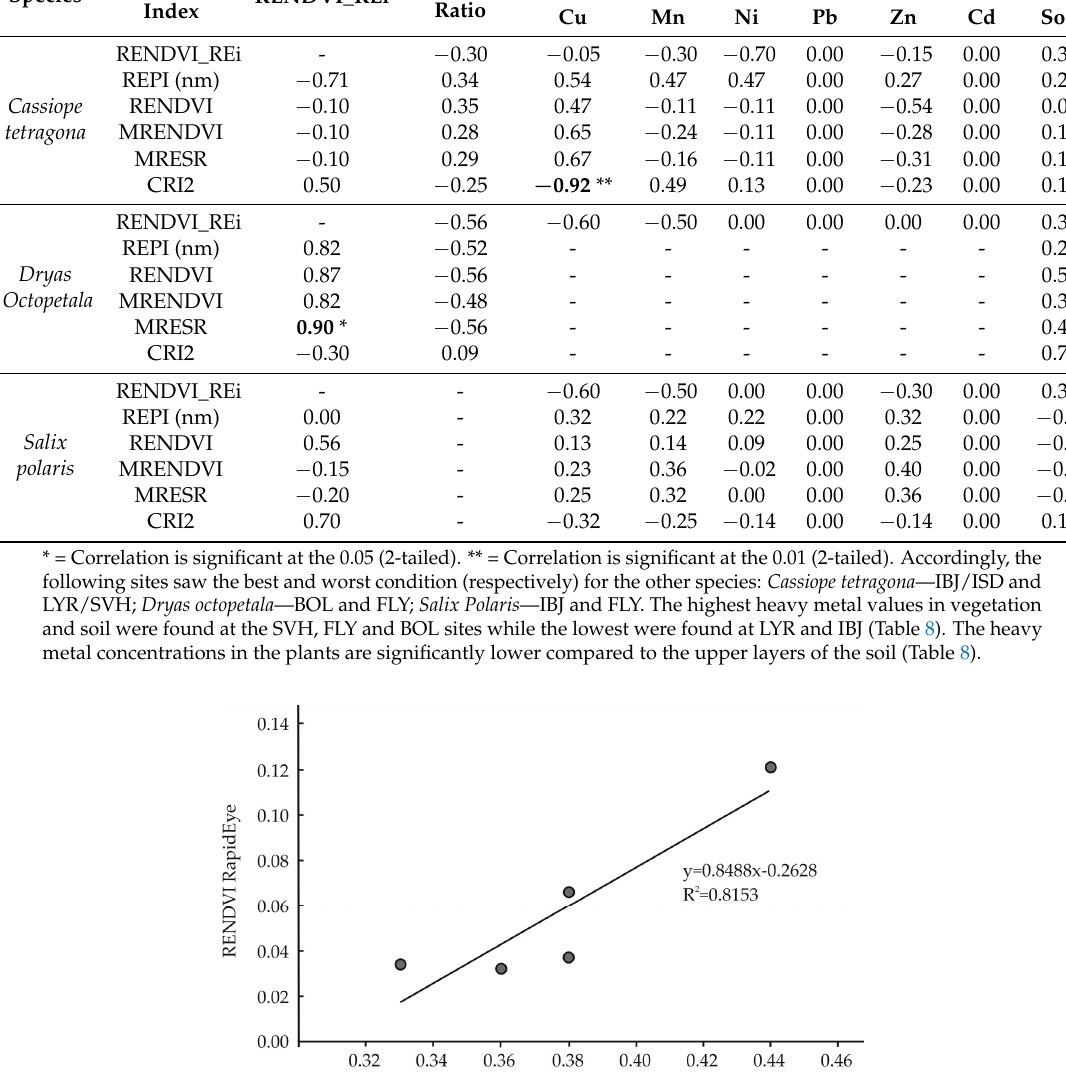
Table 9. Calculated Spearman correlation of Vegetation Indices with damage ratios and heavy metal concentrations (mg/g) in plants and soil. Test conducted at significance level <0.05. Species